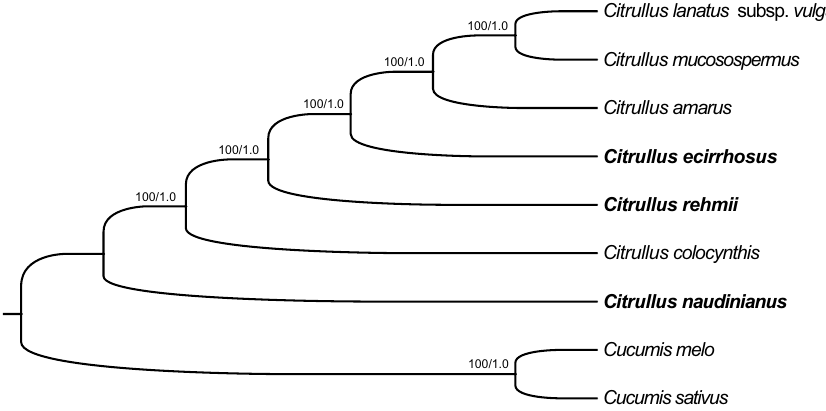
Figure 7. ML tree showing phylogenetic relationships among seven Citrullus species conducted using complete chloroplast sequences. Cucumis sativus and Cucumis melo acted as the out-group. The corresponding ML-BS/BI-PP values are given at each node. C. ecirrhosus , C. rehmii , and C. naudinianus were marked in bold characters.